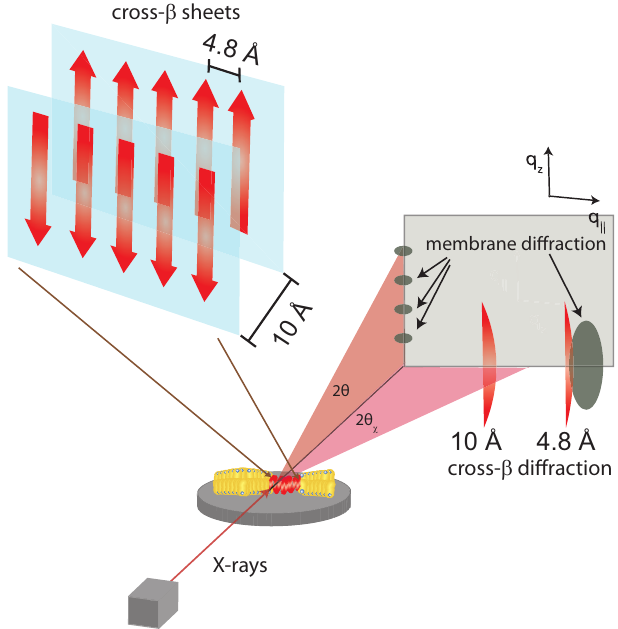
Figure 4. Structure of a cross- β sheet. The 4.8 Å distance corresponds to chain distances within a sheet while the ∼ 10 Å distance is the distance between antiparallel sheets. When cross- β sheets form in the presence of membranes, additional signals occur related to membrane stacking and packing of the acyl-tails in the hydrophobic membrane core